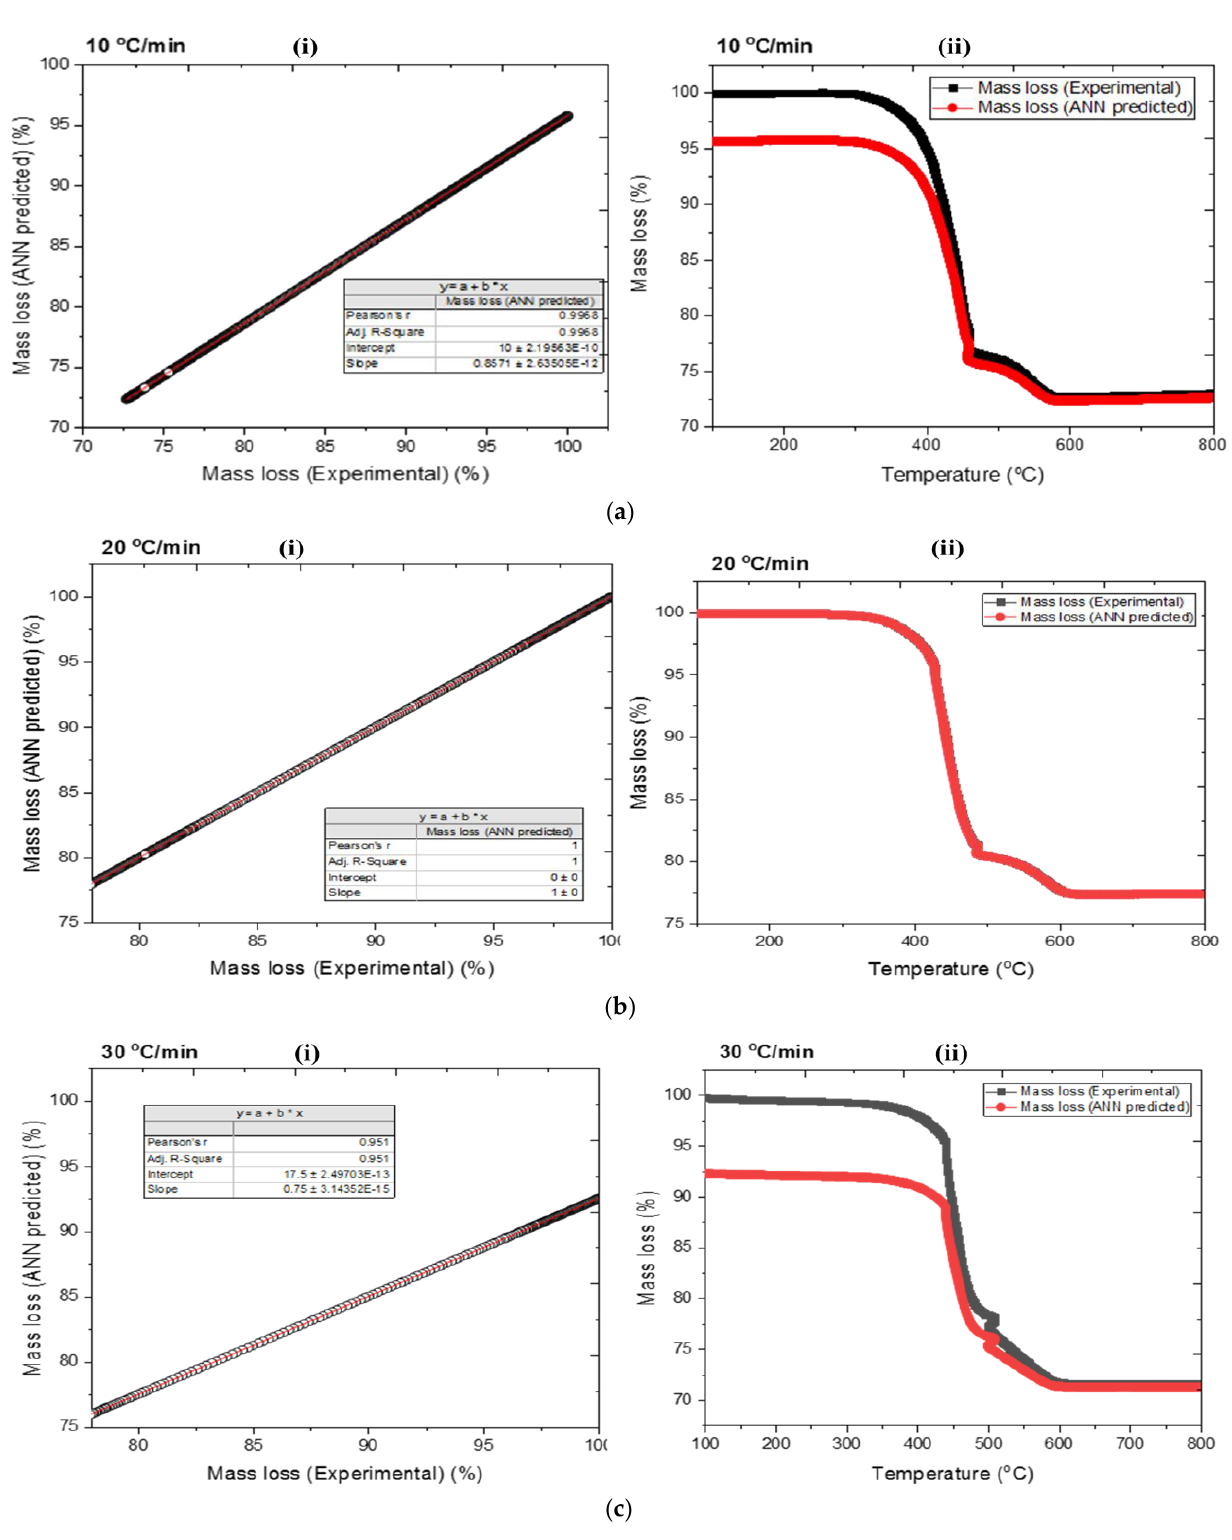
Figure 7. The linear correlation ( i ) and comparative mass loss thermogram ( ii ) of predicted PET MP degradation from the ANN and TGA systems at ( a ) 10 °C/min; ( b ) 20 °C/min; ( c ) 30 °C/min. The values of SSE and RE were then used to assess the prediction performance of the present ANN model. These values for the training and testing are listed in Table 6. The chosen ANN model has statistically significant low variances across the board,